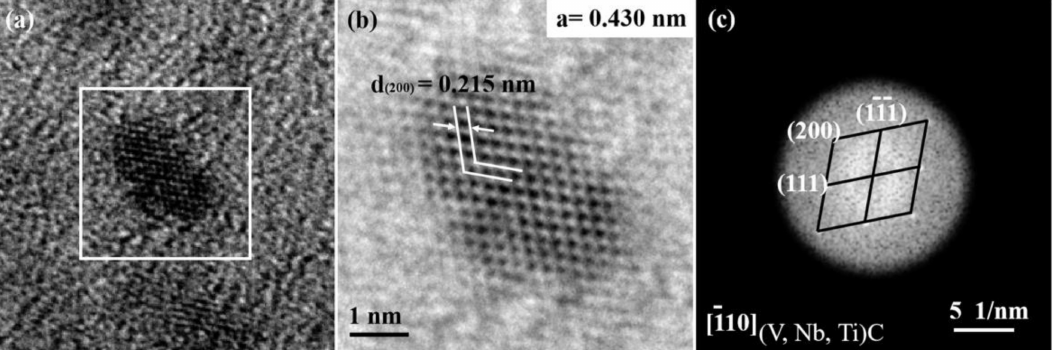
Figure 13. ( a ) TEM image of precipitates in VH steel fractured at 700 ◦ C; ( b ) crystal plane spacing and lattice constant; ( c ) the diffraction spot after the Fourier transform.